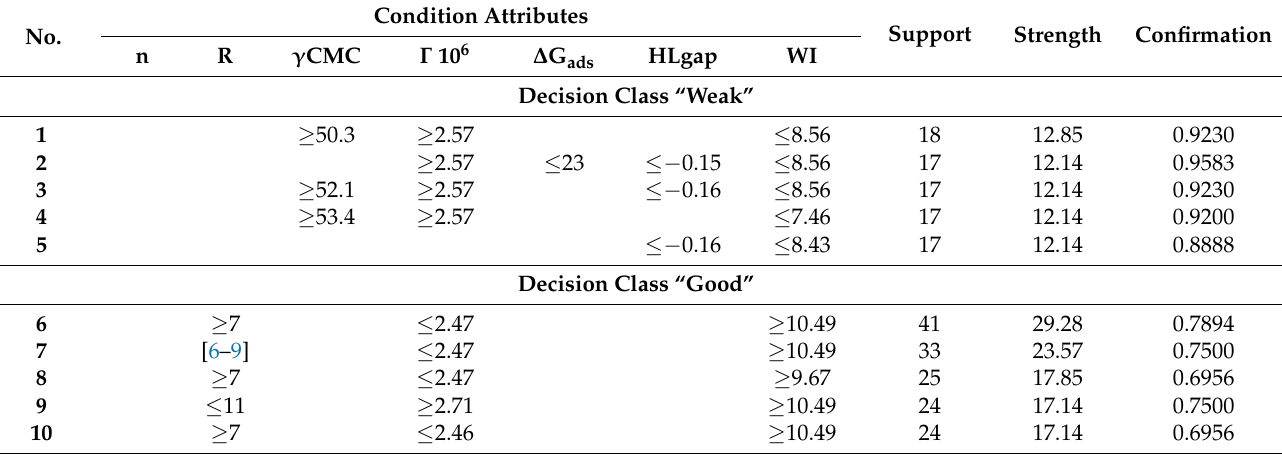
Table 1. Decision rules for SAU.